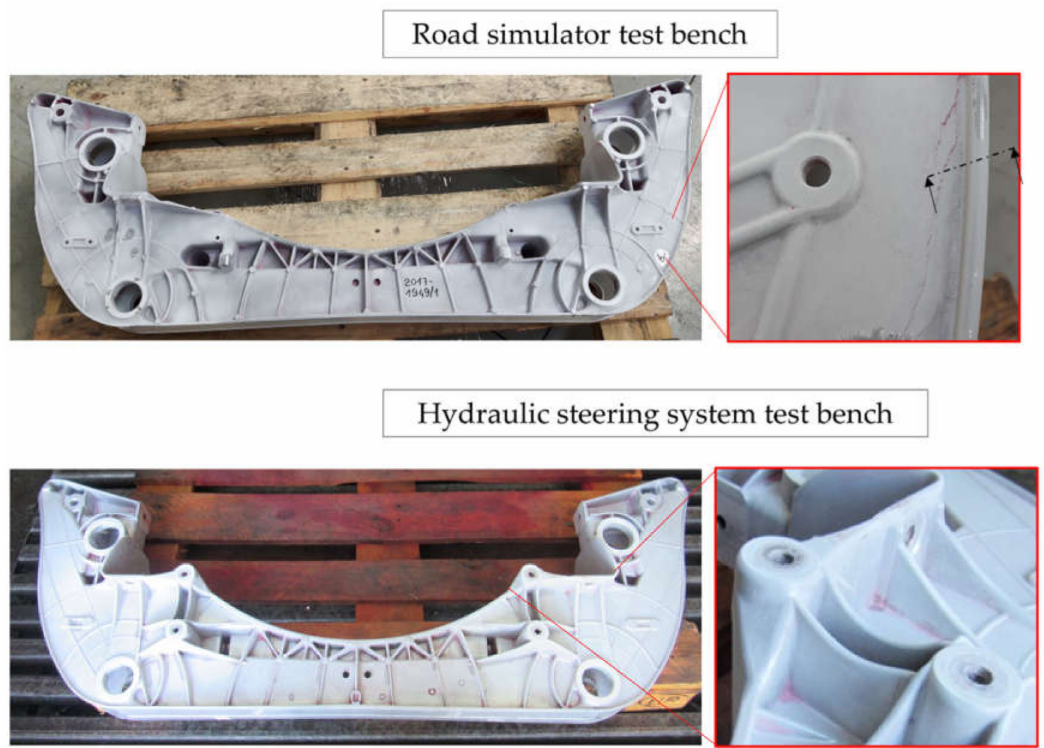
Figure 14. Liquid penetrant testing on cross beam after the road simulator and hydraulic steering system test benches. Arrows indicate the metallographic sections.